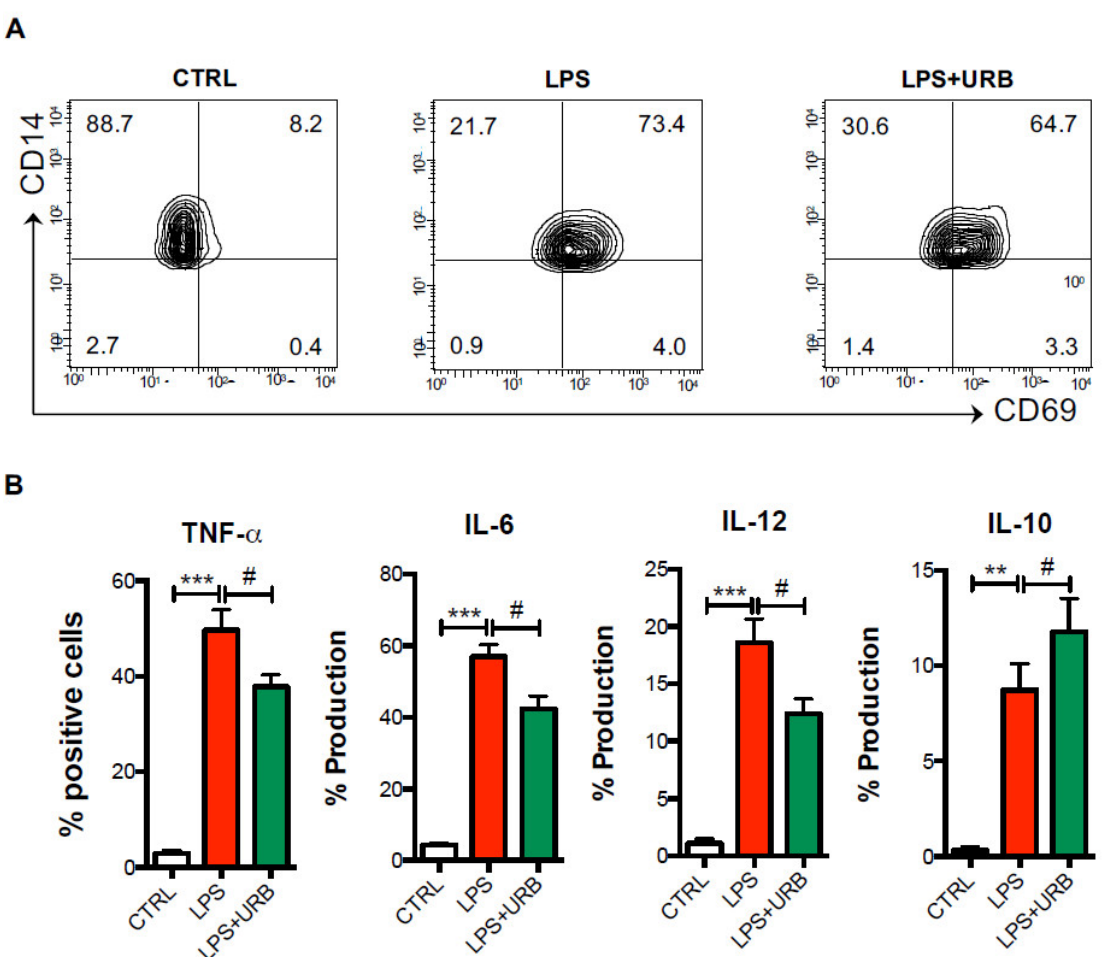
Figure 4. Pharmacological FAAH inhibition reduces monocyte inflammatory responses in AD patients. Cells from AD patients were cultured in the absence or presence of the FAAH inhibitor URB597 (URB), and then were challenged with LPS for 6 h in the presence of the exocytosis inhibitor brefeldin A as detailed in the materials and methods. By means of polychromatic flow cytometry, the surface expression of the activation marker CD69 ( A ) and intracellular production of TNF-α, IL-6, IL-12p40 and IL-10 ( B ) was measured. Data are shown as mean percentages of positive cells ± s.e.m. of 4–5 independent experiments. ** p < 0.01 and *** p < 0.005 vs. CTRL; # p < 0.05 vs. LPS.